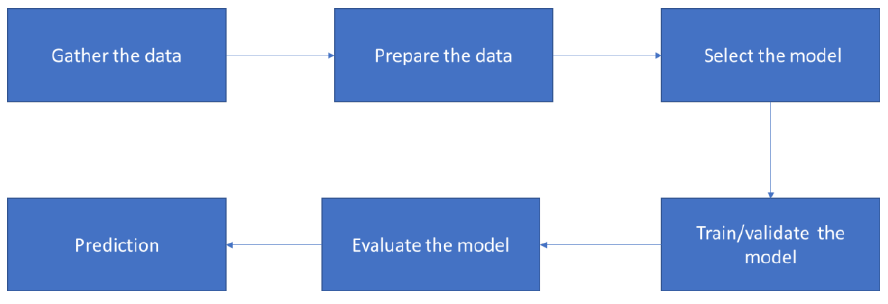
Figure 3. Steps to solve a problem using supervised learning.